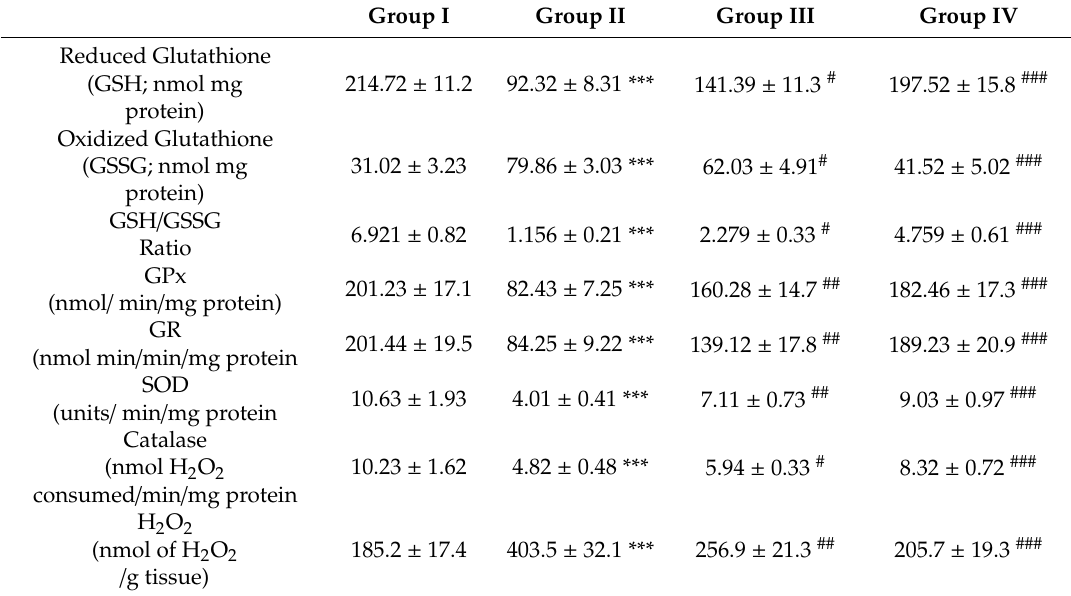
Table 1. E ff ect of Piperine on Glutathione and Antioxidant Armory.